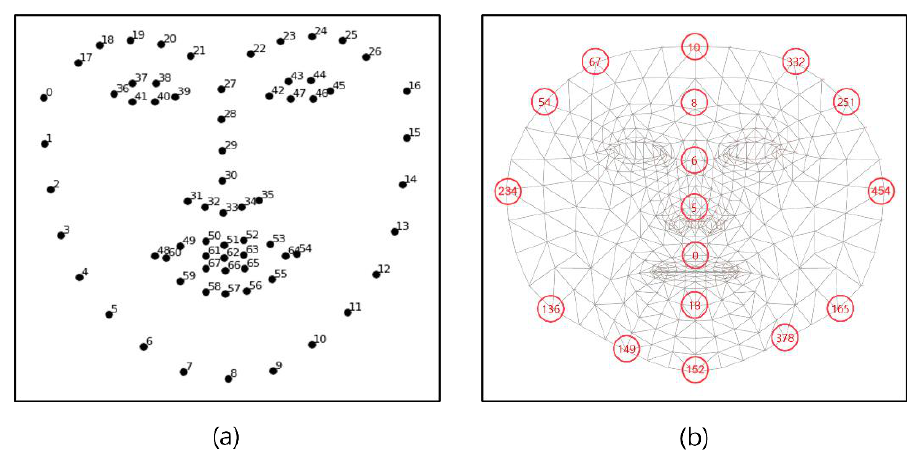
Figure 4. Open-source Face Mesh Projects ( a ) Open Face ( b ) Media-pipe.